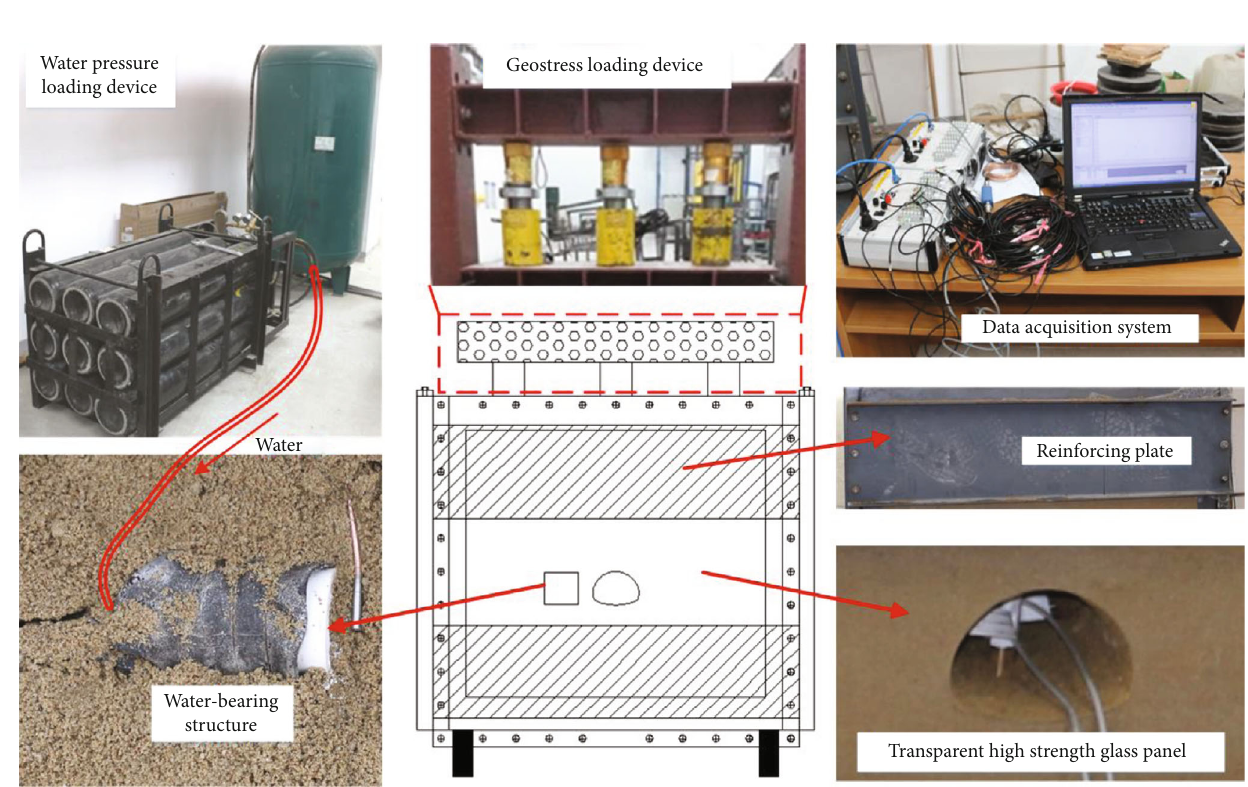
Figure 1: Experimental